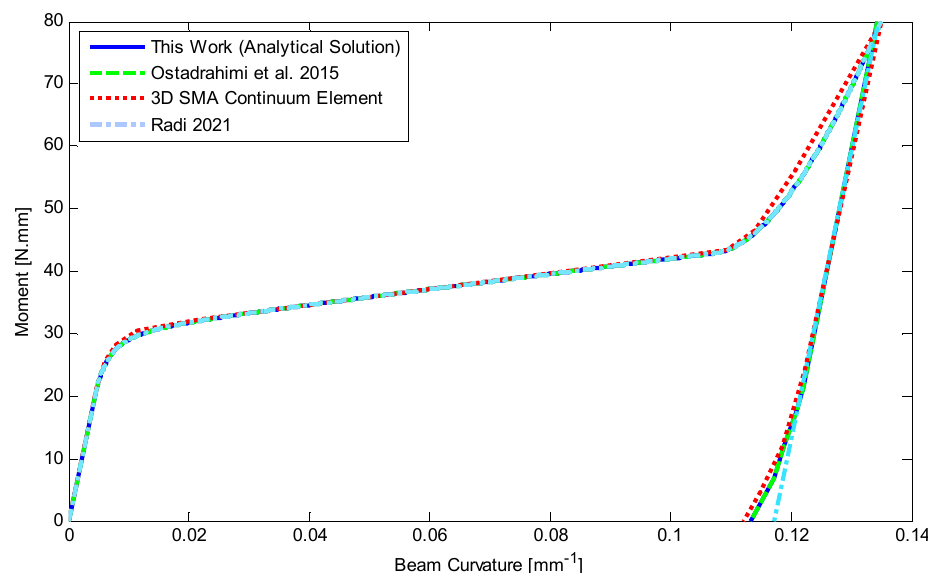
Figure 11. Comparison of analytical results considering symmetric material parameters and finite element for a rectangular SMA beam subjected to a moment of 80 N.mm at − 40 °C, [28,35].